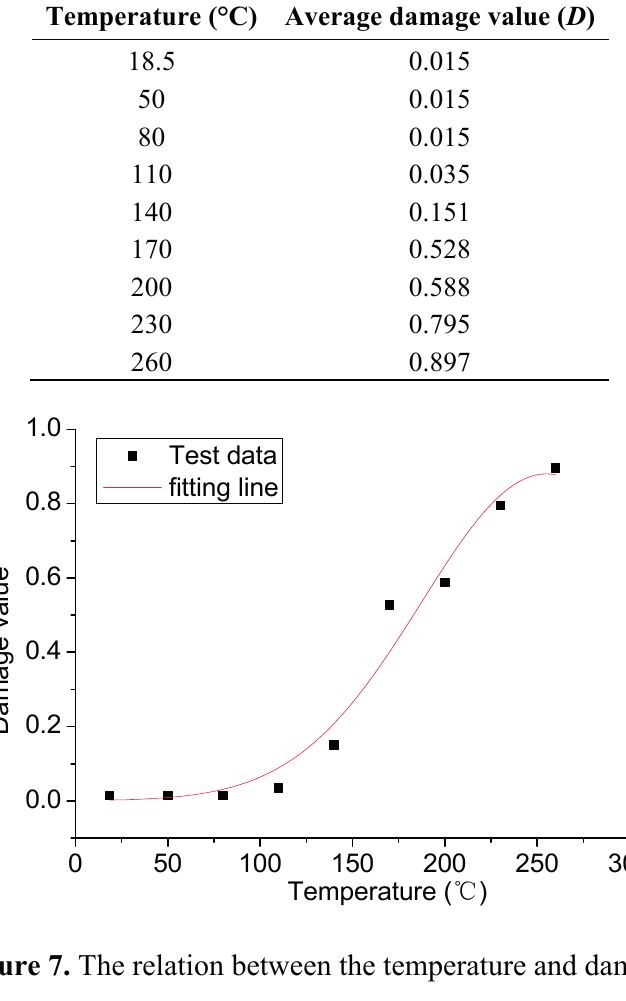
Table 1. The relation between the temperature and the damage for the thermal stress cracks.